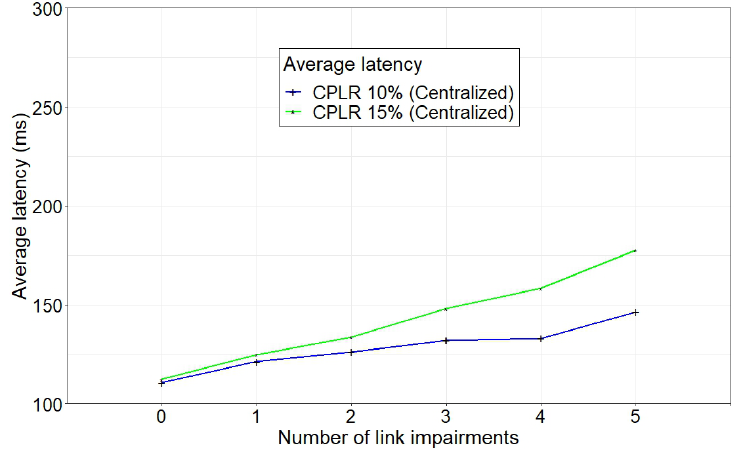
Figure 11. Average latency behavior of centralized network operation during data plane link failures for various times under unreliable control plane conditions in a 16-node grid